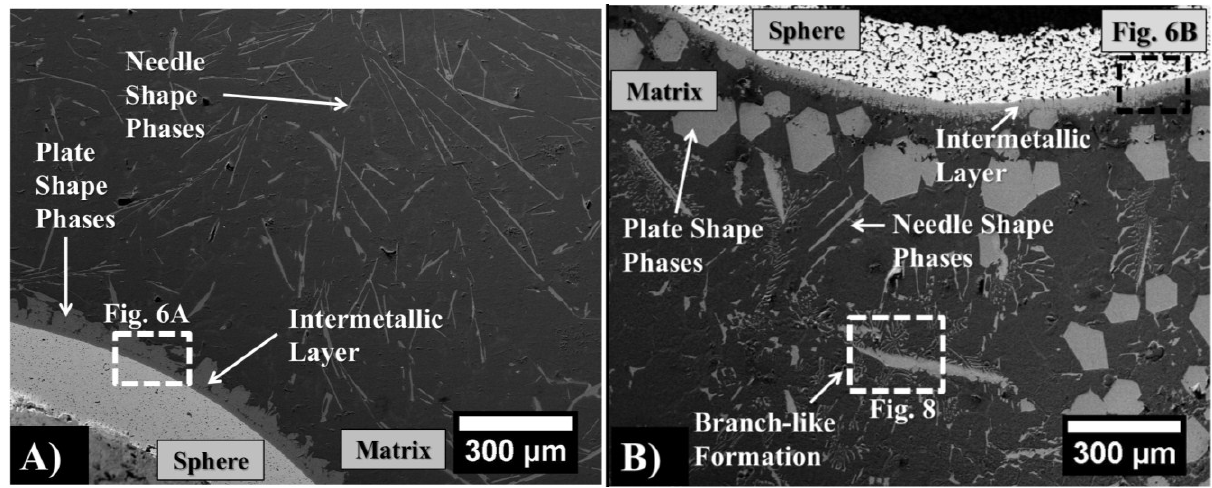
Figure 2. Backscattered SEM images of the microstructure showing intermetallic formations in Al-S CMF samples made with ( A ) 3.7 mm and ( B ) 4.0 mm spheres.